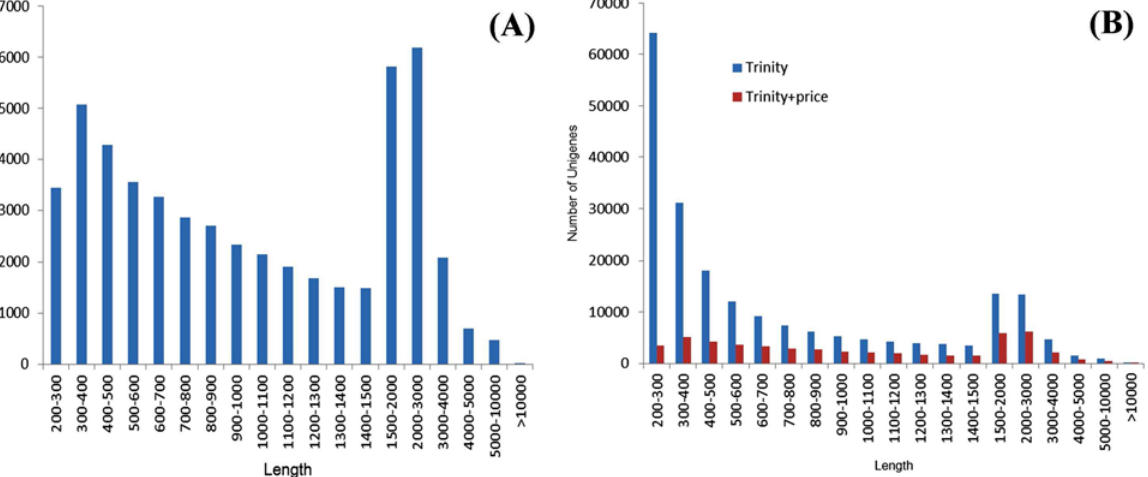
Fig 3. The length distribution (bp) of ‘ Hangbaishao ’ unigenes. (A) The length distribution of ‘ Hangbaishao ’ unigenes assembled by “ Trinity+PRICE ” . (B) Comparison of the length distribution of unigenes assembled by “ Trinity ” and “ Trinity+PRICE ”